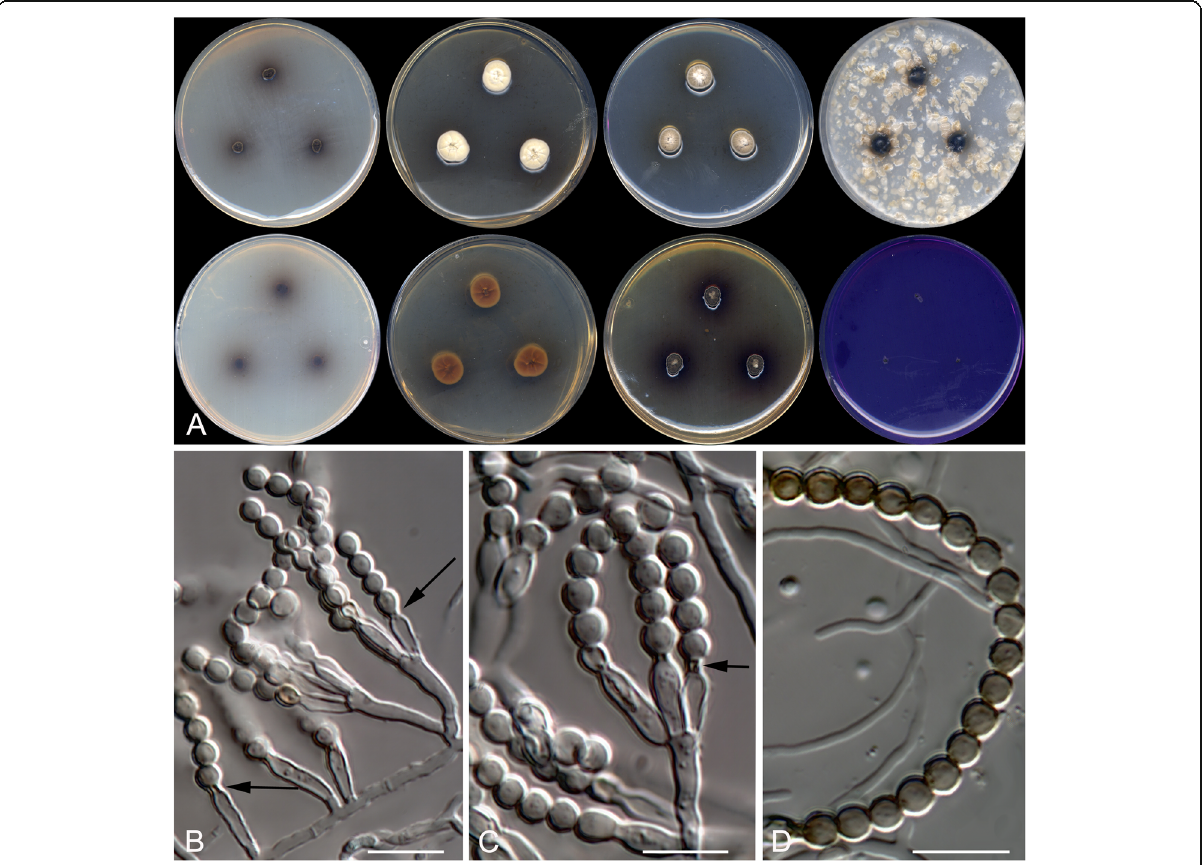
Fig. 8 Talaromyces brunneosporus CBS 144320 T . a Colonies from left to right (top row) CYA, MEA, DG18 and OA; (bottom row) CYA reverse, MEA reverse, YES and CREA. b , c Poorly-developed (single phialide) and well-developed (monoverticillate) conidiophores; the arrows indicate the conspicuous collarette at the top of the phialides. d A chain of globose, dark brown, verrucose conidia. Scale bar = 10 μ